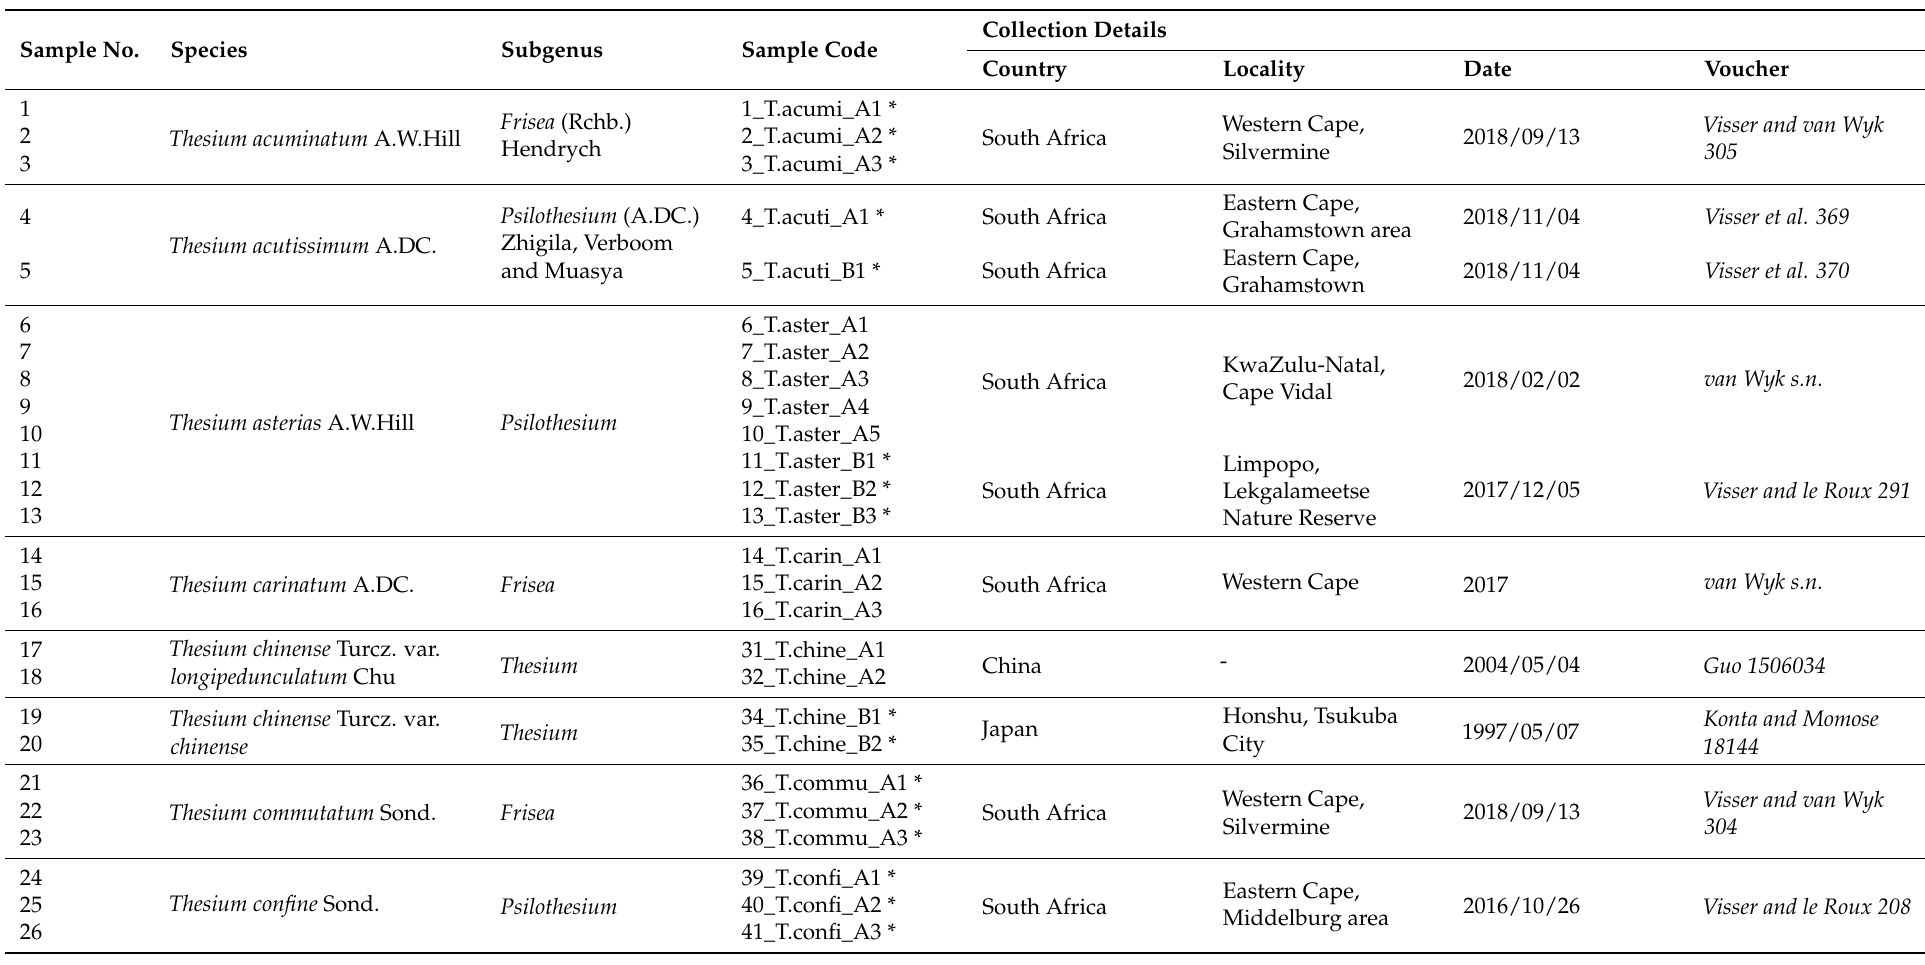
Table 1. List of samples used in this study, including their species names, subgenera, sample codes, countries of origin, collection localities and dates, and voucher details. Vouchers are housed in the Pretoria National Herbarium, South Africa (PRE). Samples included in multivariate statistics are indicated with an “*”. Sample